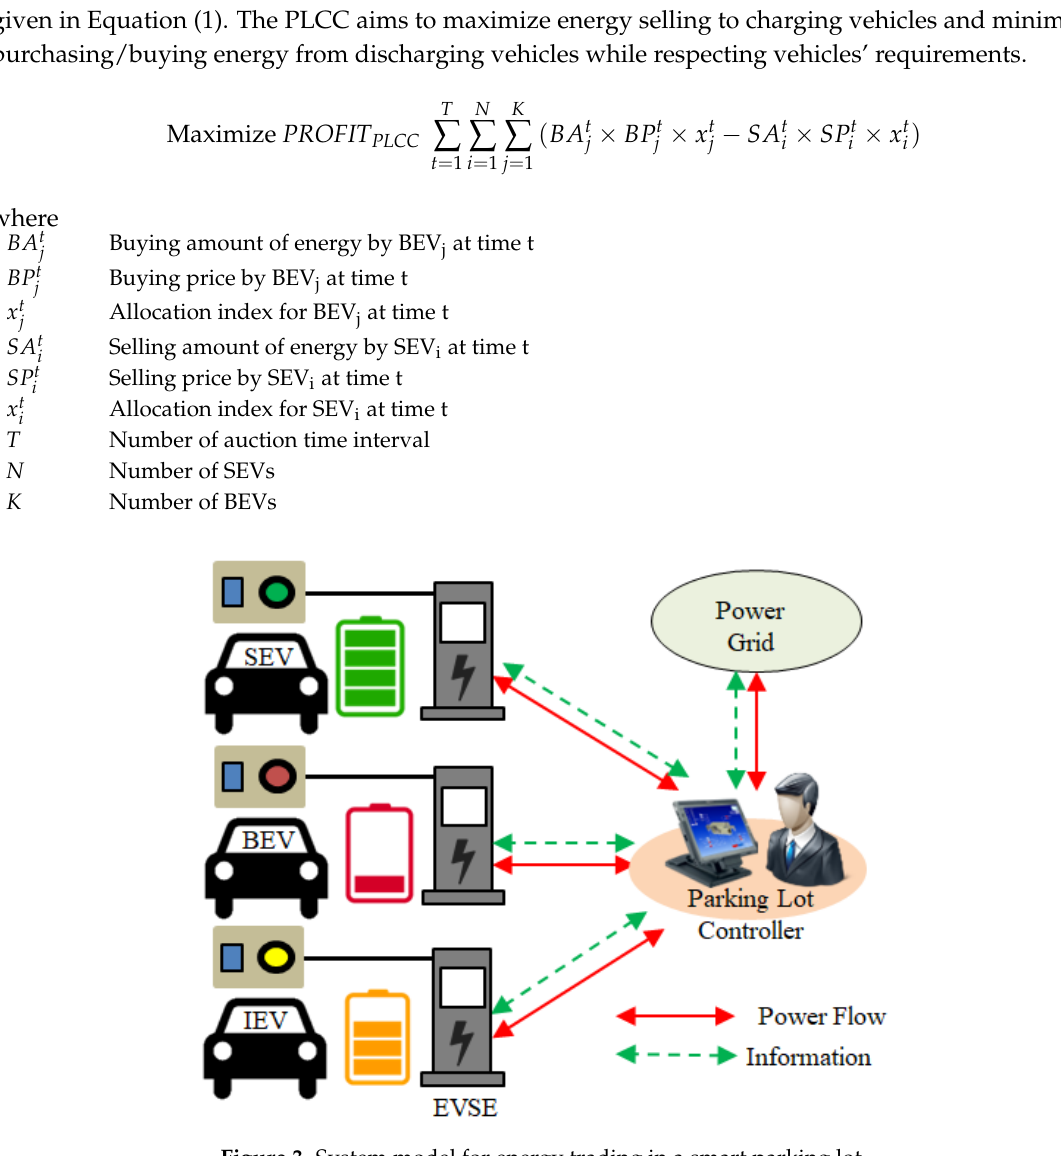
Figure 3. System model for energy trading in a smart parking lot.